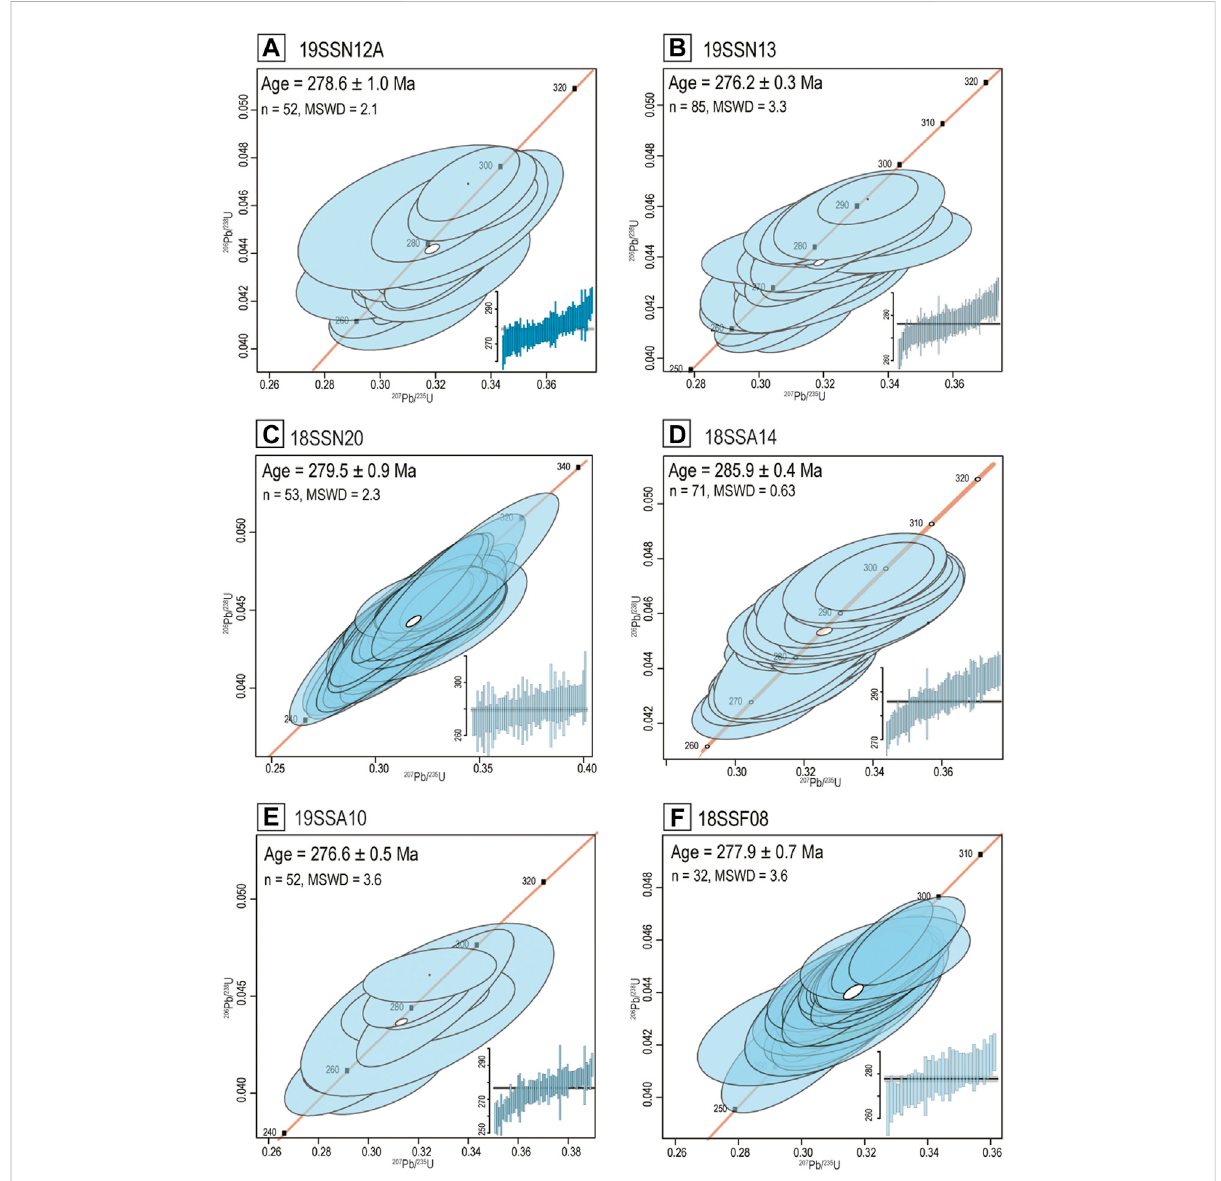
FIGURE 5 Crystallizationagesandmeansquaredweighteddeviation(MSWD)calculatedbytheweightedmeanofconcordant 206 Pb/ 238 Uagesforanalyses from orthogneisses within the Nevado-Filábride